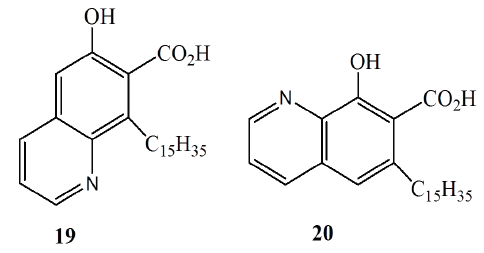
Figure 6. The benzyl amine derivatives of anacardic acid ( 18a – v ).